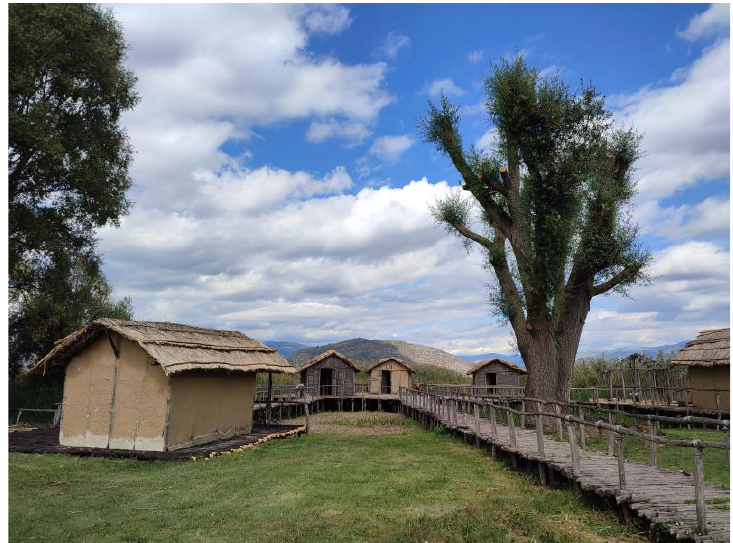
Figure 2. Α representation of the prehistoric settlement in Dispilio . Figure 2. A representation of the prehistoric settlement in